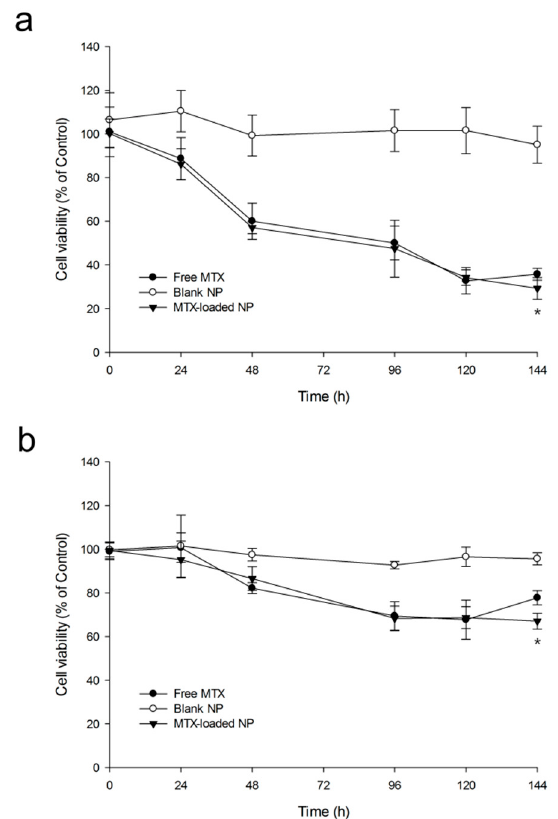
Figure 7. Viabilities of CWR22Rv1 cells ( a ) and MCF-7 cells ( b ) after treated with free MTX (0.01 mg / mL), blank NPs, or MTX-loaded NPs (0.01 mg / mL as MTX) ( n = 3, mean ± SD). * p < 0.05 between prepared PLGA NPs and free MTX